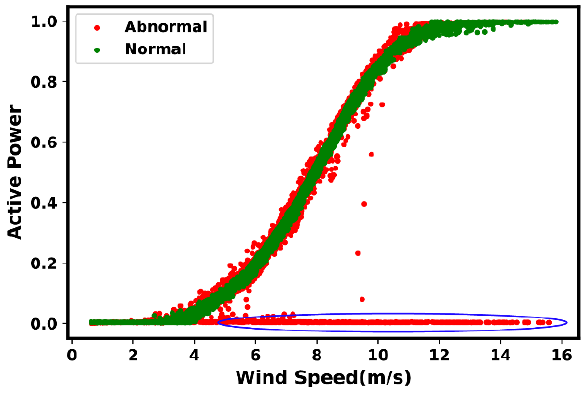
Figure 6. Type 1: Lower Stacked Data.